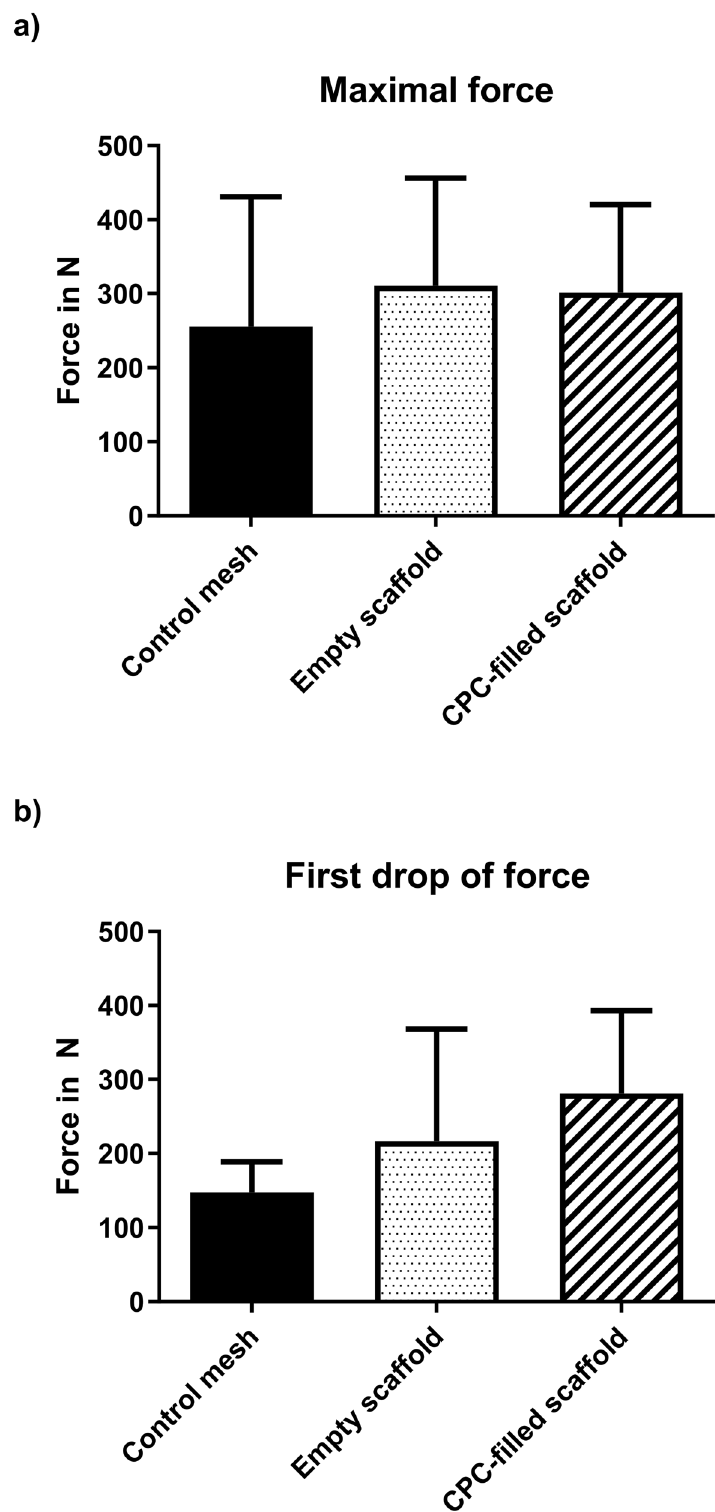
Fig. 5 Push-out tests showing only minimal differences among the different experimental setups [( a ): Maximum force; ( b ): First drop of